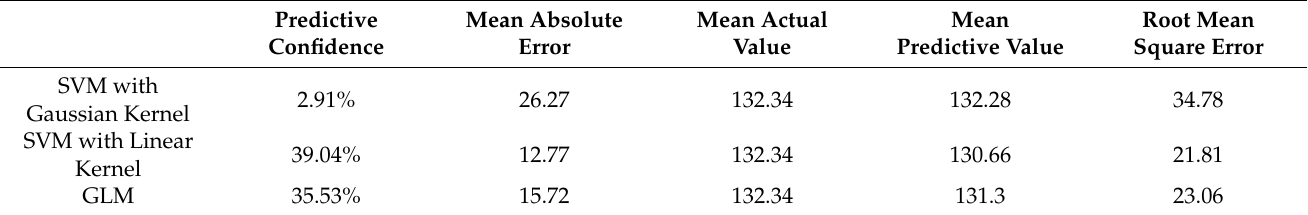
Table 6. Results of the main metrics after generating models for the cohort of holidays.